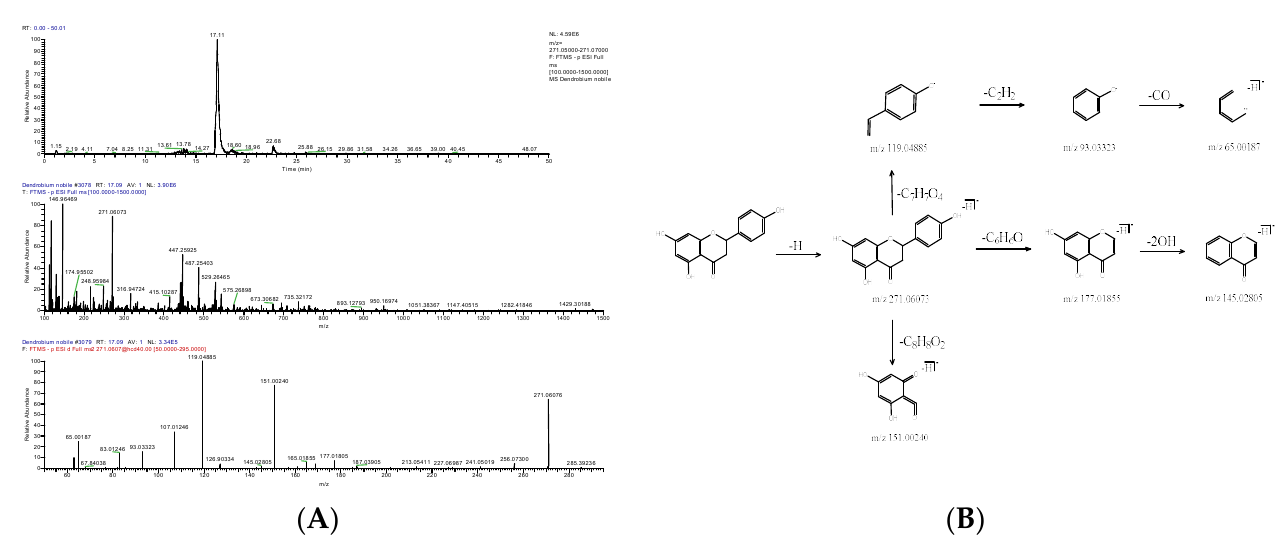
Figure 8. Extracted ion chromatogram: MS 1 and MS 2 spectra in negative ion mode ( A ), and proposed main fragments of naringenin (DN 23) ( B ).